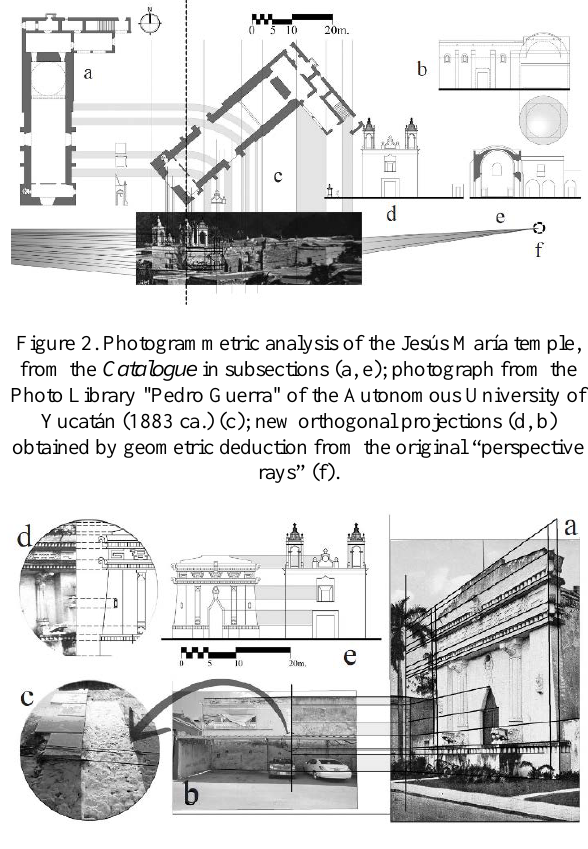
Figure 3. Photogrammetric analysis of the Grand Lodge The Oriental Peninsular based on the original photographs (a, d) and physical remains present in the adjoining walls (c, b) to give a reference and obtain the